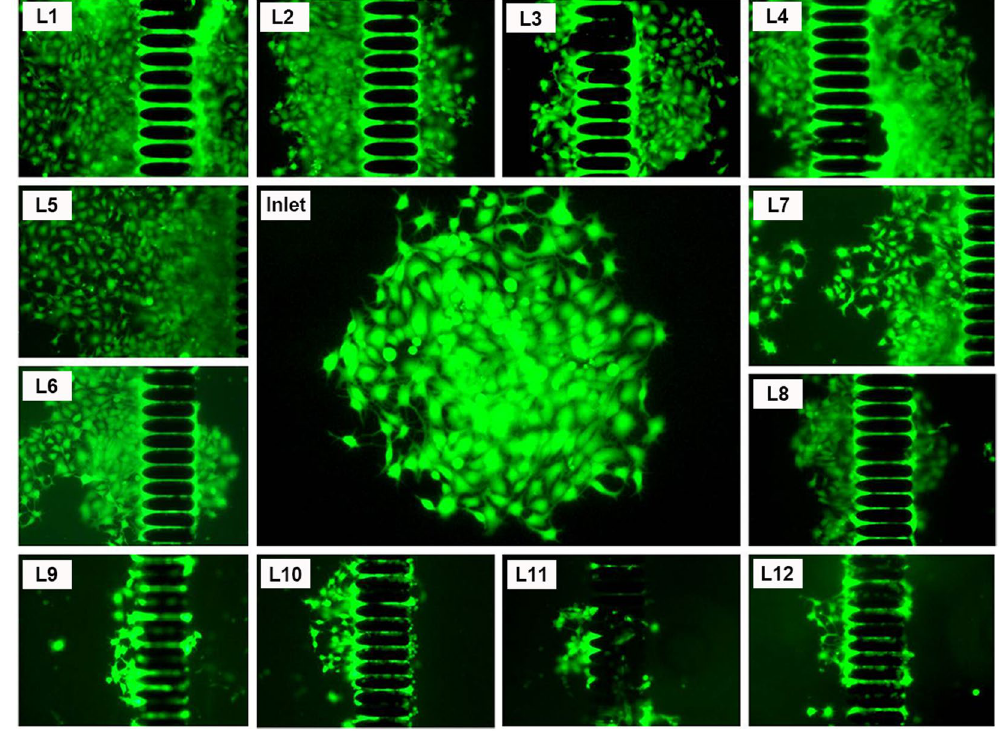
Figure 6. Fluorescence images of re-cultured MCF-7captured on micro-ellipse filters from L1 to L12 including inlet after 6